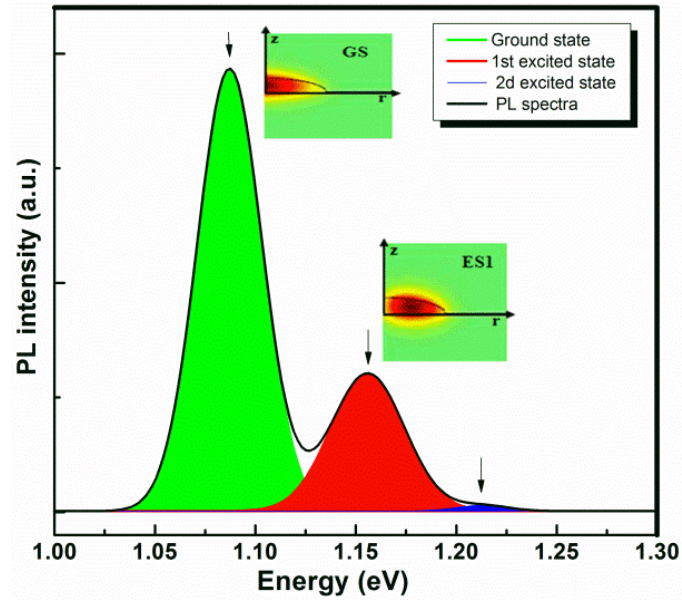
Figure 2. 12 K photoluminescence spectroscopy (PL) spectra taken with an excitation power of 400 mW, from the reference InAs QDs in a pure GaAs matrix showing a ground state and two excited states emission peaks. The arrows indicate the calculated transition energies. The electron envelope functions are also shown as